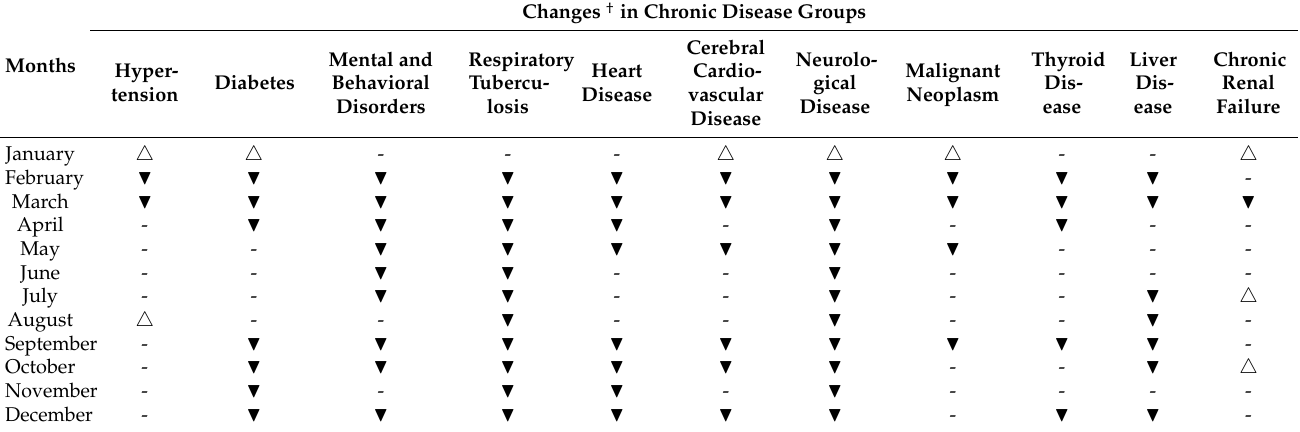
Table 4. Assessment of the Pandemic’s Impact on Monthly OP visits in 2020 (11 chronic disease